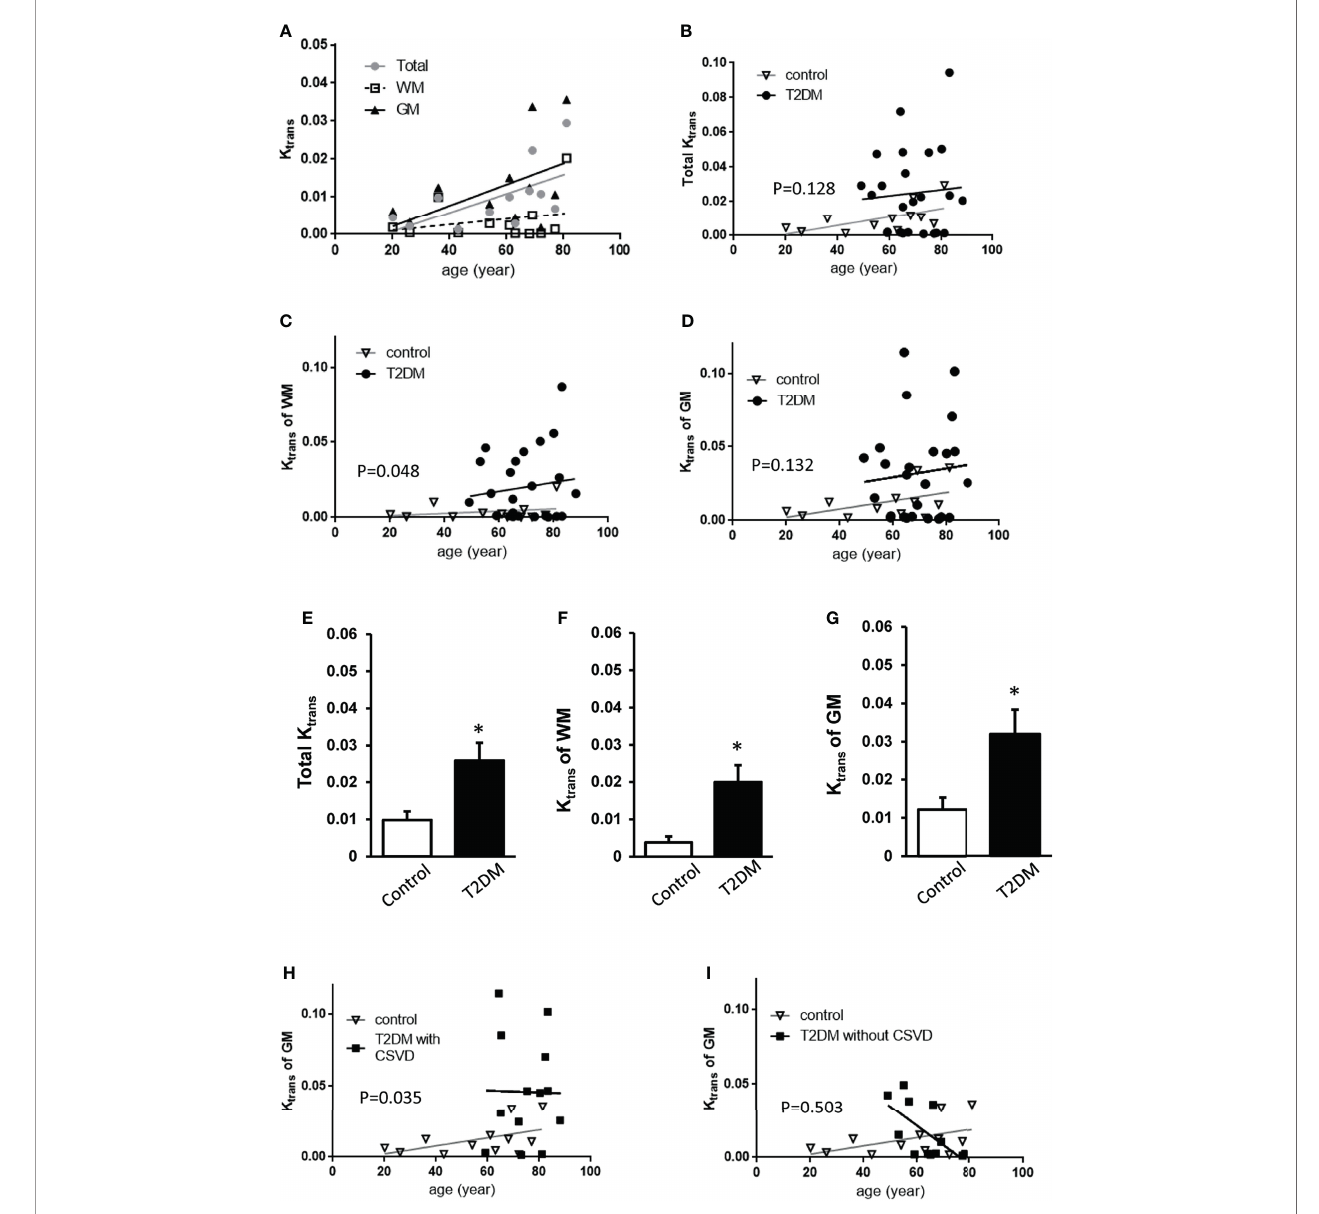
FIGURE 2 | Comparisons of K trans among control, T2DM, and T2DM with CSVD groups. (A) The averaged total K trans , K trans of the WM, and GM plotted against age in the control group ( N = 12). (B – D) The total K trans (B) , K trans of the WM (C) , and GM (D) plotted against age in T2DM ( N = 25) and control groups ( N = 12). (E – G) Comparisons of total K trans (E) , K trans of the white matter (WM) (F) , and K trans of the gray matter (GM) (G) between patients with T2DM and controls. Unpaired t -test. * p < 0.05. (H, I) The K trans of the GM plotted against age in T2DM with CSVD and the control group (H) and in T2DM without CSVD and the control group (I) . A permutation-based linear model with 10,000 random shuf fl ings. x -axis, age; y -axis, K trans . WM, white matter; GM, gray matter; T2DM, type 2 diabetes mellitus; CSVD, cerebral small vessel